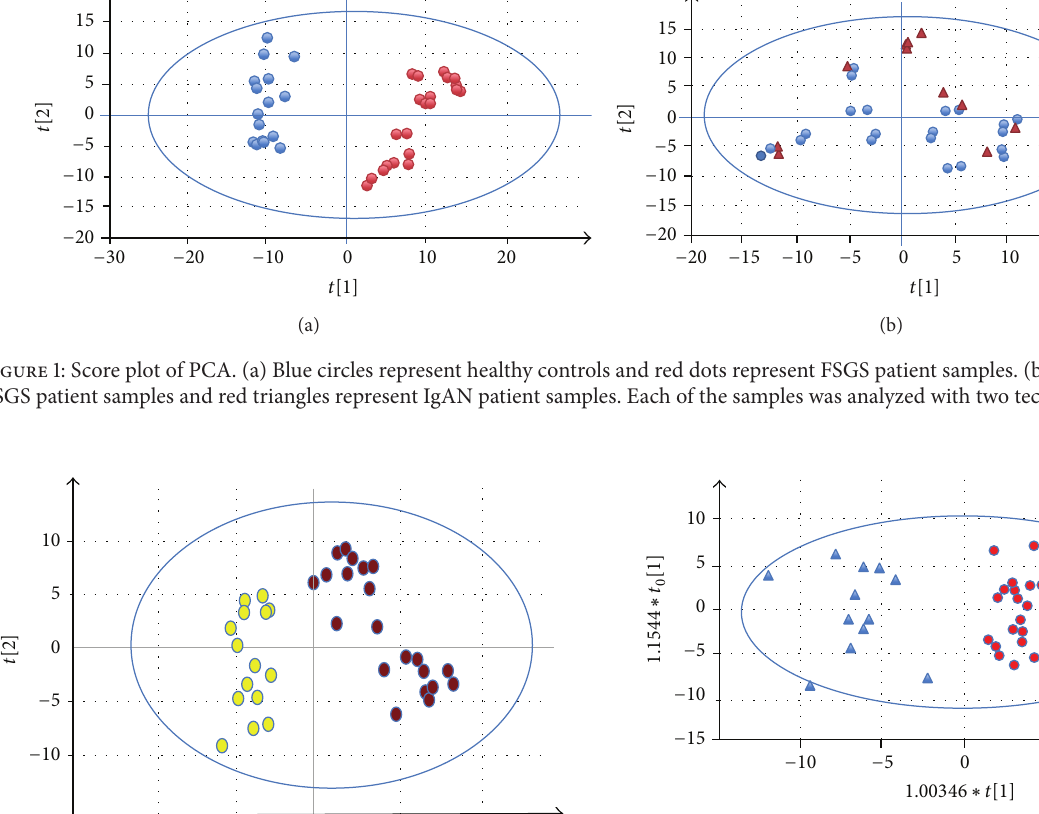
Figure 3: Predictive model (FSGS/IgAN). Orthogonal projections to latent structures discriminant analysis (OPLS-DA) model for discrimination of FSGS (red dots) and IgAN (blue triangles) patient